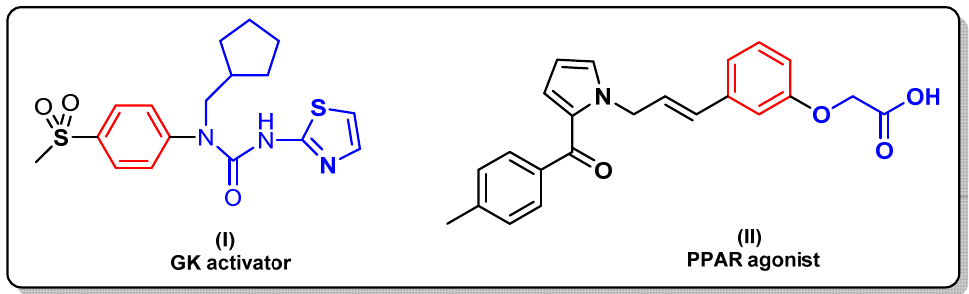
Figure 1. Reported antidiabetic agents.